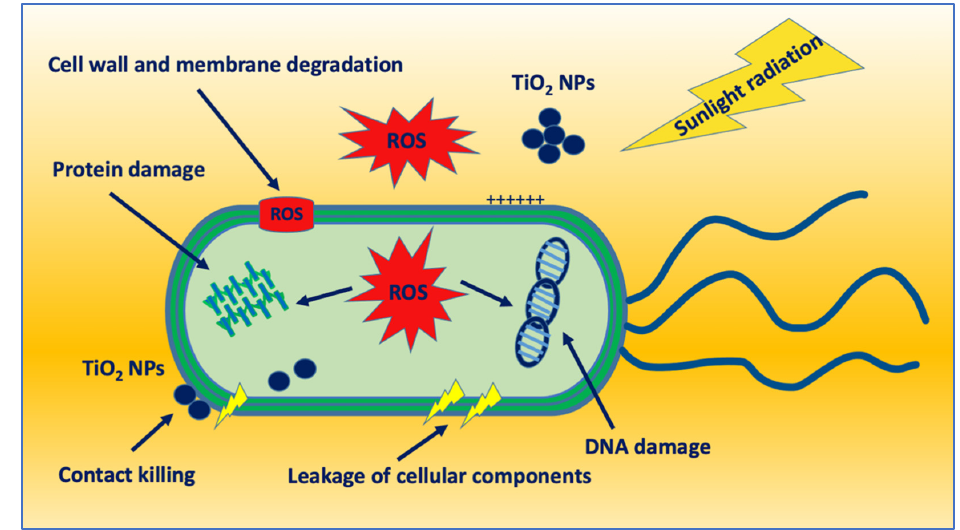
Figure 3. Schematic representation of the antibacterial activity of TiO 2 NPs.